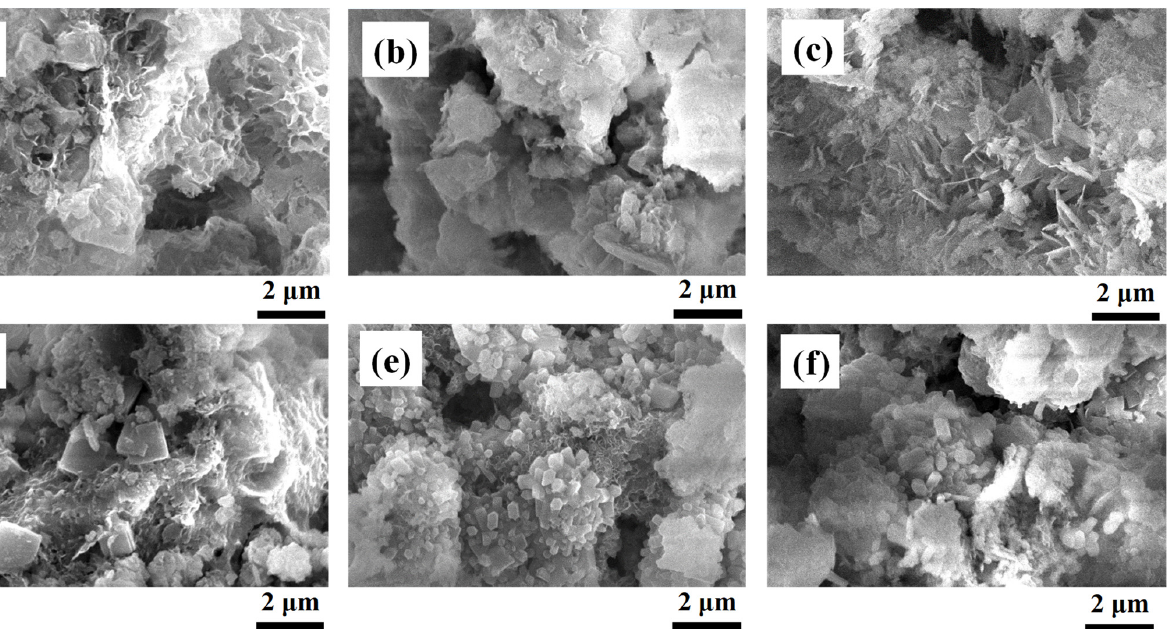
Figure 8. XRD patterns of the products synthesized at 80 °C ( a ) without the addition of 1 M EDTA and ( b ) with 1 M EDTA during the synthesis reaction (NaOH concentration: 3 M NaOH). The concentrations of Si, Al, and Ca during synthesis with and without 1 M EDTA are shown in Figure 9, and the relative crystallinities of the product phases and CECs of 0